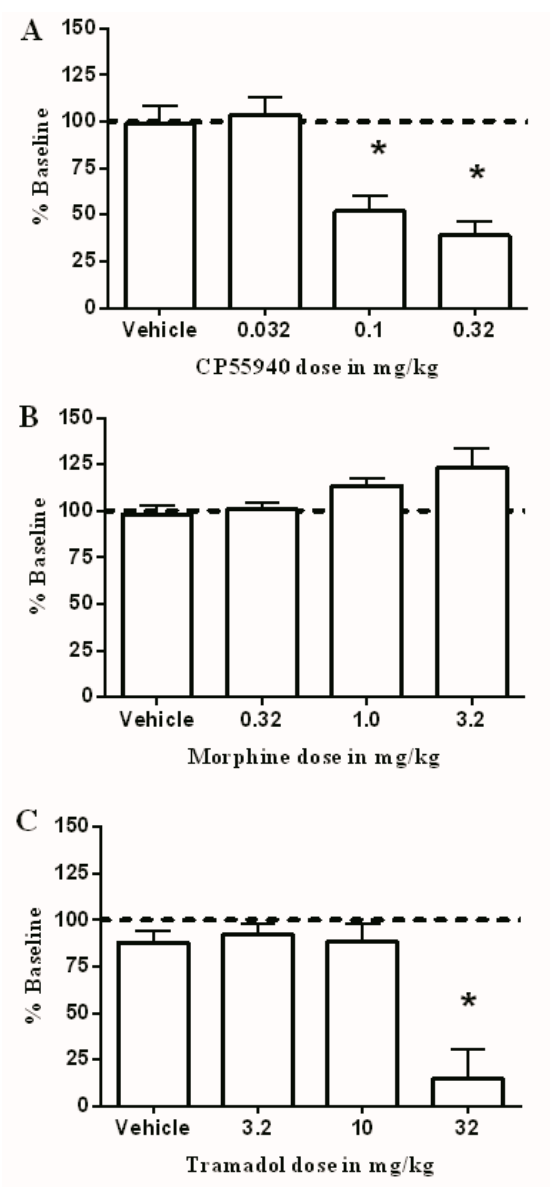
Figure 3. Effect of CP55940 ( A ), morphine ( B ), or tramadol ( C ) and their combination on intracranial self-stimulation in rats. Abscissae: dose of drug. Ordinates: percent baseline stimulations per test component. Data were analyzed using the one way ANOVA test followed by Dunnett’s post hoc test (* p < 0.05, n = 6 rats per group).